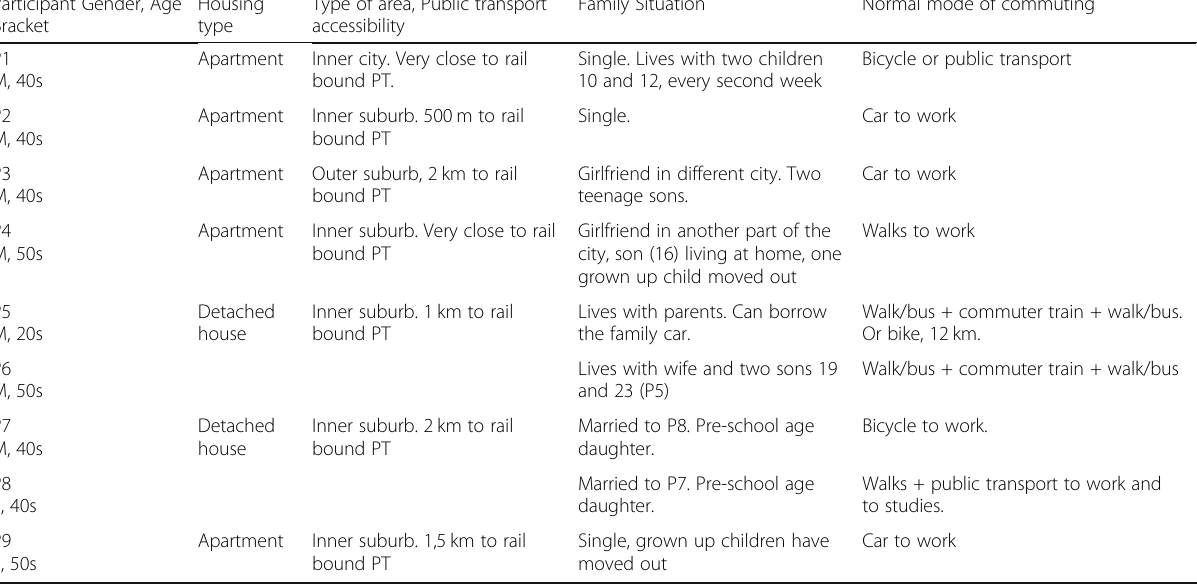
Table 1 Participants in the Living Lab Participant Gender, Age Bracket